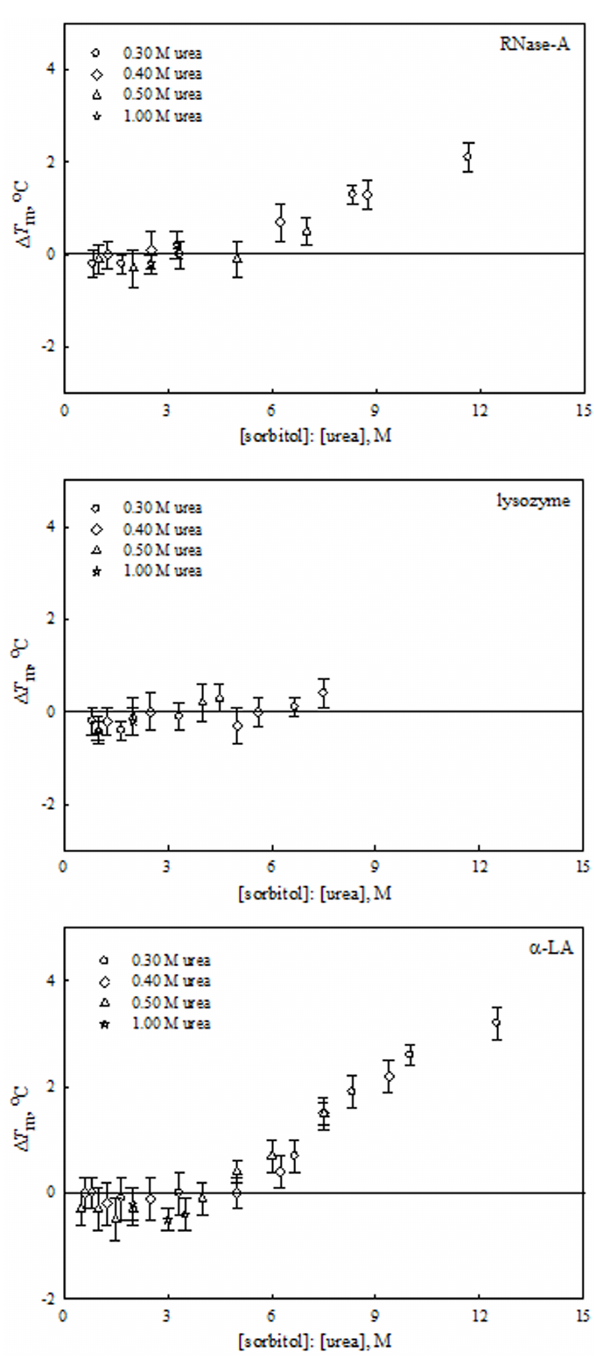
Figure 7. Effect of [sorbitol]: [urea] mixtures at different ratios on the stability of proteins at pH 7.0 and 25 u C. Plots of D T m versus different combined ratios of [sorbitol]: [urea] mixtures.